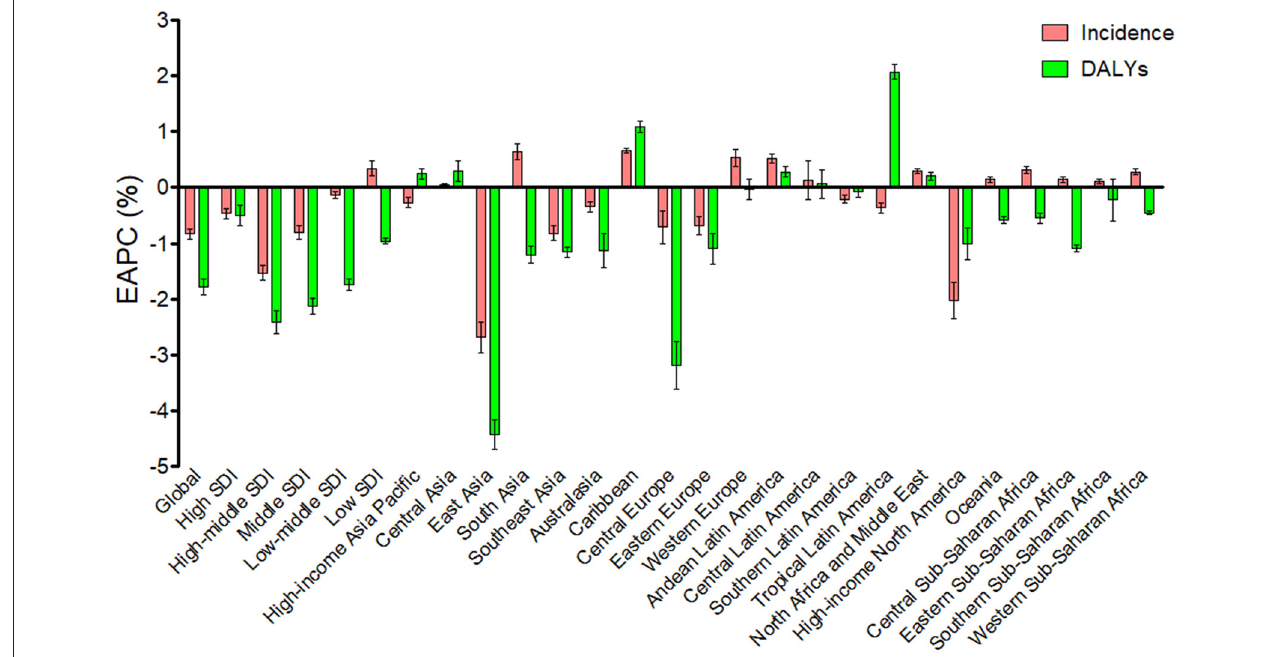
FIGURE 1 | The EAPC of age-standardized incidence and DALYs rates of urolithisis at the global and regional levels.